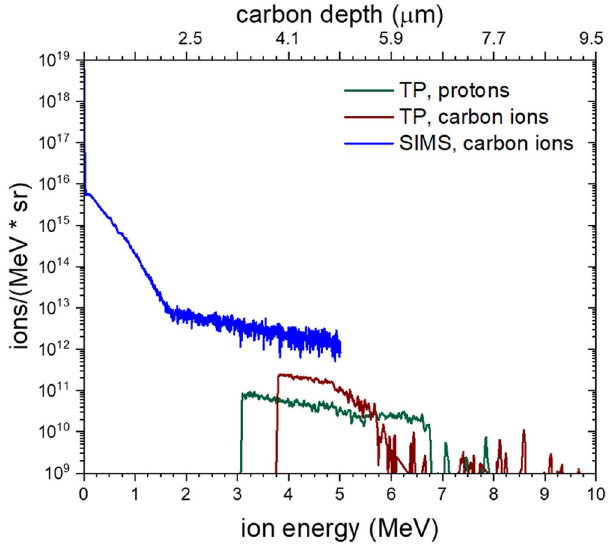
Fig. 3 Examples of Thomson parabola (TP) data for protons and C 4 + ions, together with a Secondary Ion Mass Spectrometry (SIMS) depth pro fi le for all carbon ions. The red lines show extrapolations of the TP and SIMS data to low energies. A carbon concentration from SIMS of 10 16 atoms cm − 3 corresponds to 10 13 ions MeV -1 sr -1 in the comparison with TP data.